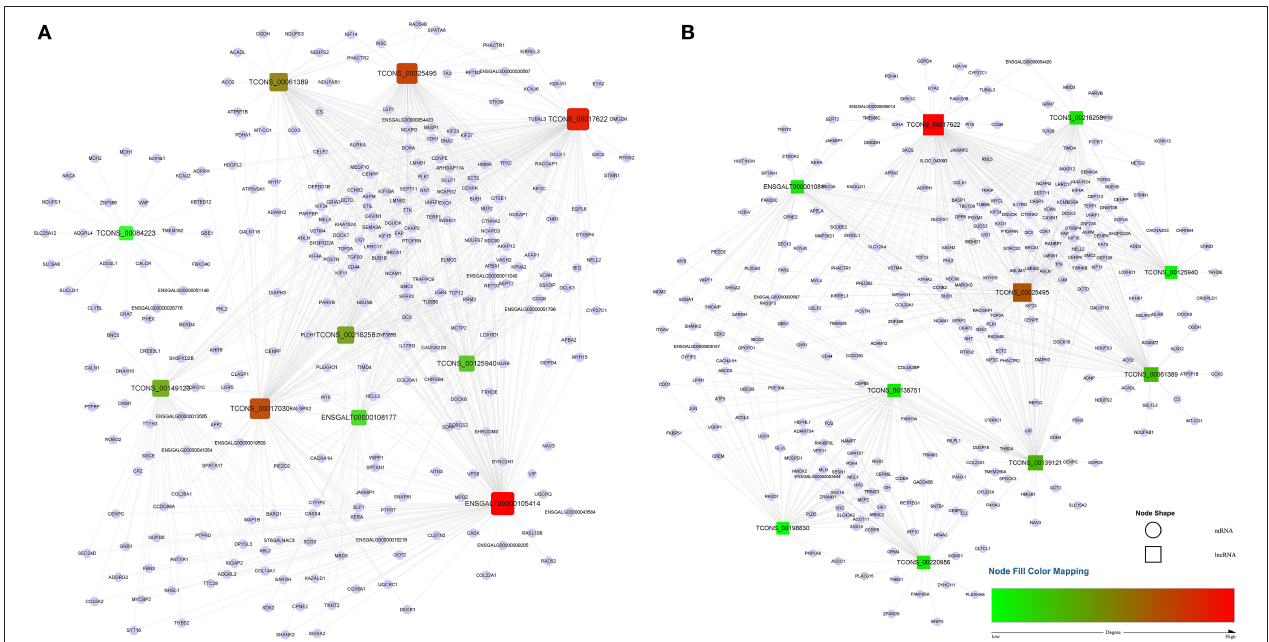
FIGURE 5 | lncRNA-mRNA co-expression networks for the top 10 lncRNAs. (A) lncRNA-mRNA network of F14vsF20; (B) lncRNA-mRNA network of S14vsS20. Red indicates high degree and green indicates low